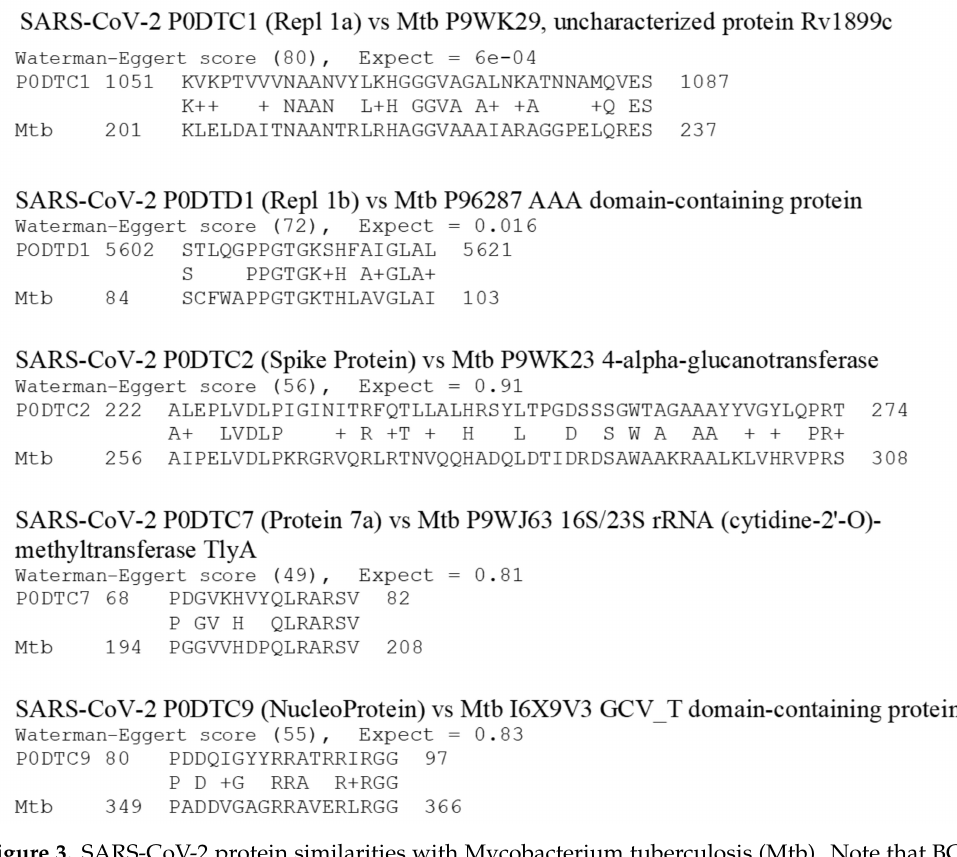
Figure 3. SARS-CoV-2 protein similarities with Mycobacterium tuberculosis (Mtb). Note that